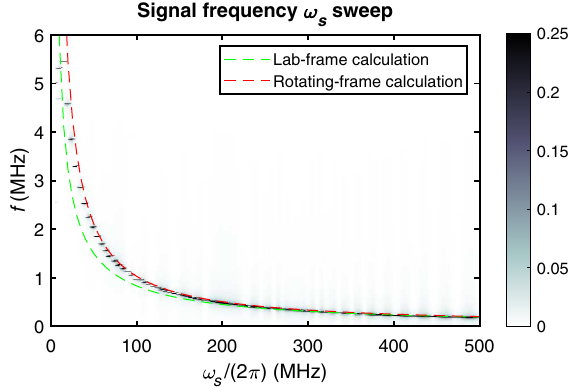
FIG. 5. Signal frequency ω s sweep simulation. The population on initial state j 0 i is measured as P ð t Þ , and the intensity plot is j 0 i the Fourier spectrum of P ð t Þ . Both the signal (along z ) and j 0 i bias field are linearly polarized with ϕ b ; ϕ s ¼ π = 2 , 0 and Ω b ¼ Ω 2 π Þ 10 MHz. The resonance condition ω ω ω sz ¼ ð b ¼ s þ 0 with ω 0 ¼ ð 2 π Þ 50 MHz is satisfied. The calculation in the lab frame is given by Eq. (B3), and the one in the rotating frame is given by Eq. (B8) with the ac Stark shift taken into account (see Supplemental Material for more